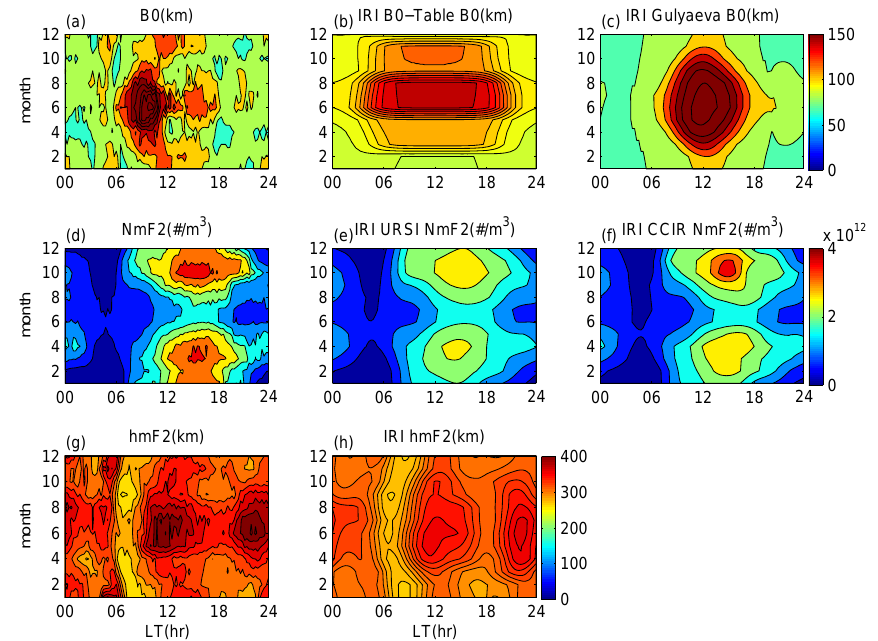
Fig. 2. Variations observed in the monthly median B0, Nm F2, and hm F2 values measured from ionosonde (left panels) and IRI-2007 (middle and right panels) during